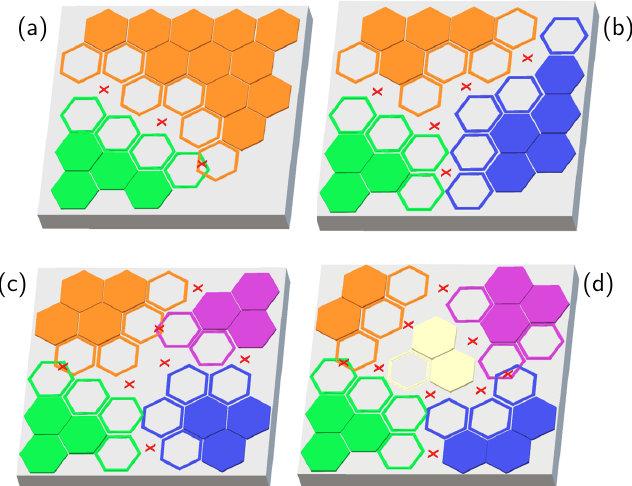
Figure 5. A schematic of the relationship between nuclei surface density and the surface zones available for chemisorption. In the picture, a chemisorbed molecule is represented by a fully colored shape. In contrast, the empty structure represent the surface spots where the depositing molecules could chemisorb when captured by a nucleus, identified by its color. Marked areas are either overlaps between incompatible chemisorption sites or are unavailable for developing a chemical bond with a depositing molecule. The schematic shows that the available surface diminishes with more nuclei occupying the same surface portion. Examples with ( a ) two, ( b ) three, ( c ) four, and ( d ) five